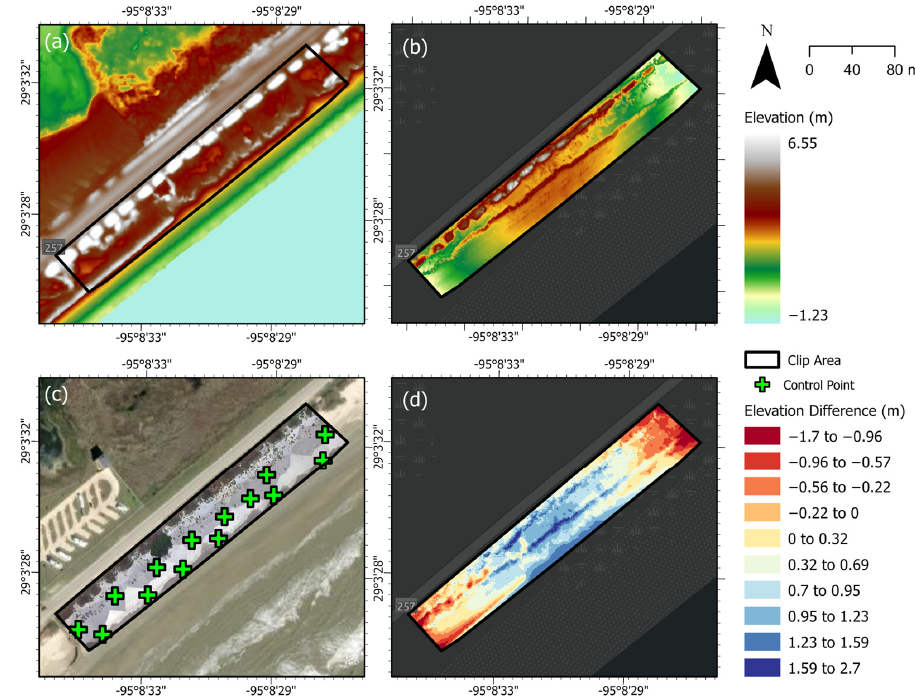
Figure 17. Follett’s Site 3 comparison of 2022 UAV data and 2018/2019 data. Spatial Reference: NAD 1983 UTM Zone 15n. ( a ) 2018/2019 NOAA’s Post Hurricane Harvey elevation model with survey clipping boundary; ( b ) May 2022 digital elevation model; ( c ) May 2022 orthophoto with a World Imagery Maxar base map; ( d ) The elevation difference map with erosion represented as orange through red, and deposition represented by yellow to blue.